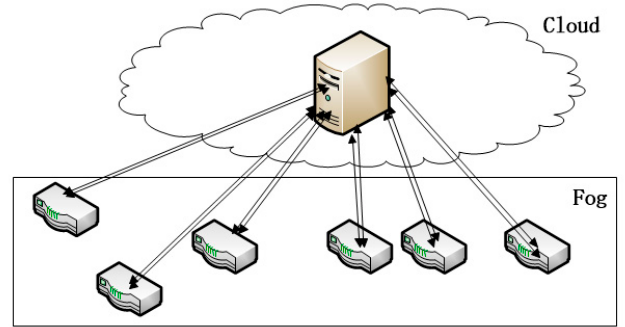
Figure 8. Cooperative game between FCNs.